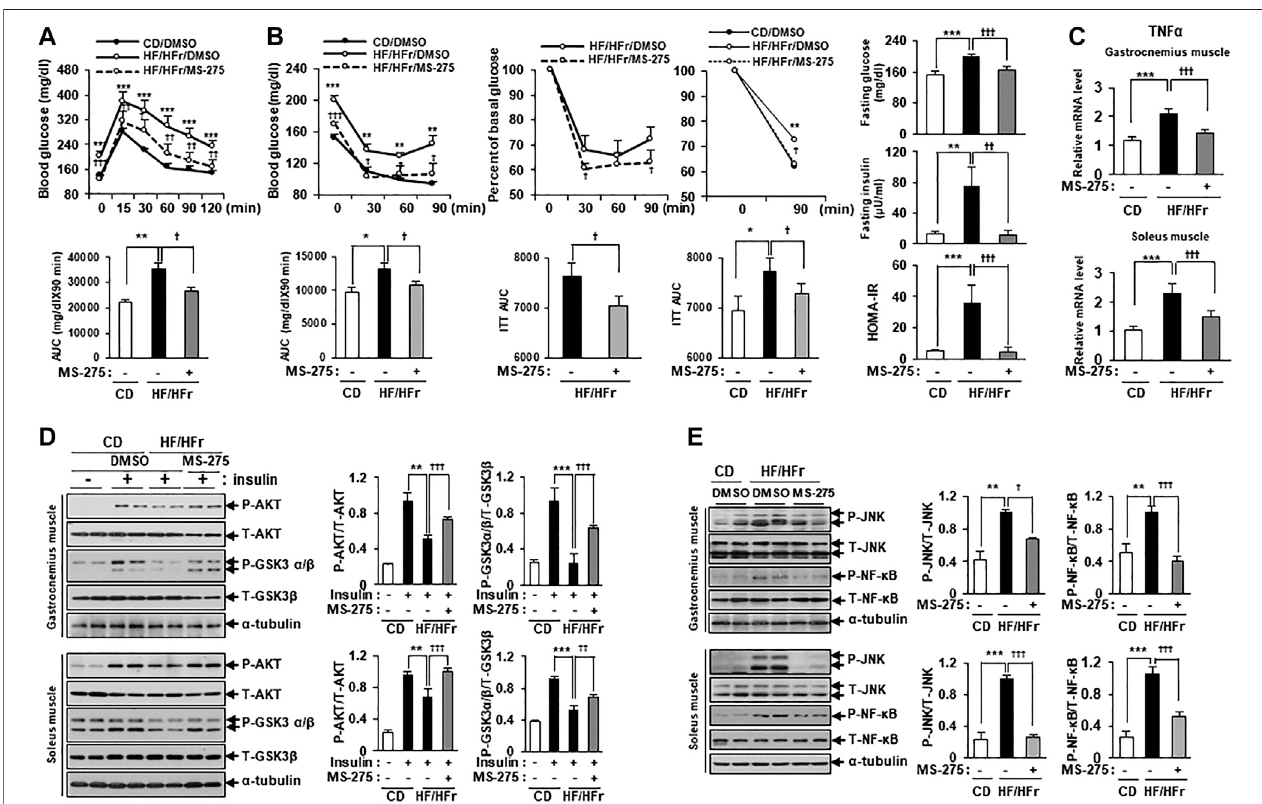
FIGURE 6 | MS-275 ameliorated HF/HFr-induced insulin resistance and in fl ammation in skeletal muscle from C57BL/6J mice. (A) To assess blood glucose levels, mice were fasted for 6 h and then intraperitoneally injected with glucose (1 g/kg). Blood glucose levels were measured at the indicated times using an Accu-Chek glucometer (Roche Diagnostics). The area under the curve (AUC) was obtained from an intraperitoneal glucose tolerance test (IPGTT). ** p < 0.01; *** p < 0.001 vs. CD mice, † p < 0.05; †† p < 0.005; ††† p < 0.001 vs. HF/HFr mice. (B) Mice were fasted for 6 h and then intraperitoneally injected with insulin (0.7 U/kg) and then Blood glucoselevel were analyzed byACCU-CHEK during IPITT. AUC was obtained from an intraperitoneal insulin tolerance test (IPITT).* p < 0.05; ** p < 0.01; *** p < 0.001 vs. CD mice, † p < 0.05; ††† p < 0.001 vs. HF/HFr mice. Percent of basal glucose level and the inverse integrated area under the glucose curve during IPITT. * p < 0.05; ** p < 0.01 vs. CD mice, † p < 0.05 vs. HF/HFr mice. To assess fasting glucose and insulin levels, after serum sample collection, plasma insulin concentration was analyzed by ELISAdescribedinMethods.HOMA-IRwascalculatedasdescribedinMethods.** p < 0.01;*** p < 0.001vs.CDmice, †† p < 0.01; ††† p < 0.001vs.HF/HFrmice. (C) The relativeexpression of TNF α gene related to in fl ammation in gastrocnemius muscle or soleusmuscle, respectively wasdetermined by real-time PCR. *** p < 0.001 vs. CD mice, ††† p < 0.001 vs. HF/HFr mice. (D) Levels of insulin signaling molecules after insulin stimulation in gastrocnemius muscle or soleus muscle, respectively were analyzed by Western blot using anti-p-AKT and anti-p-GSK3 β antibodies. ** p < 0.01; *** p < 0.001 vs. insulin-stimulated CD mice, †† p < 0.01; ††† p < 0.001 vs. insulin- stimulatedHF/HFrmice. (E) Thelevelsofstress/in fl ammationsignalingmoleculesingastrocnemiusmuscleorsoleusmuscle,respectivelywereanalyzedbyWesternblot using anti-p-JNK and anti-p-NF- κ B antibodies. ** p < 0.01; *** p < 0.001 vs. CD mice, † p < 0.05; ††† p < 0.001 vs. HF/HFr